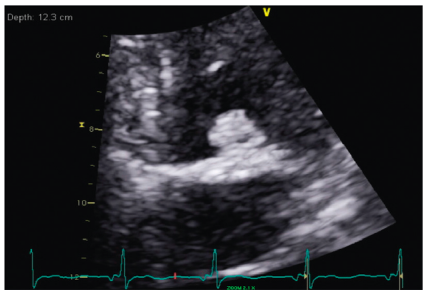
Figure 3: Transthoracicechocardiogram(TTE)showinga1.2 × 1.2cm mobile mass attached to the ventricular aspect of mitral valve and hyperechogenic mitral